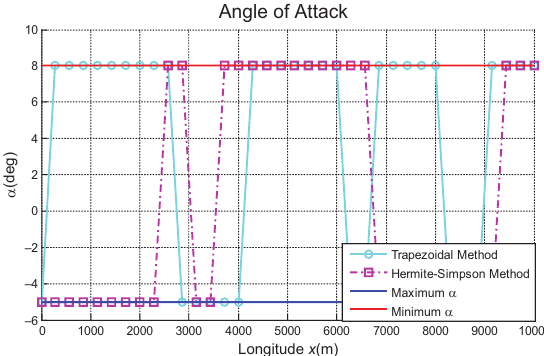
Figure 10. History of the angle of attack